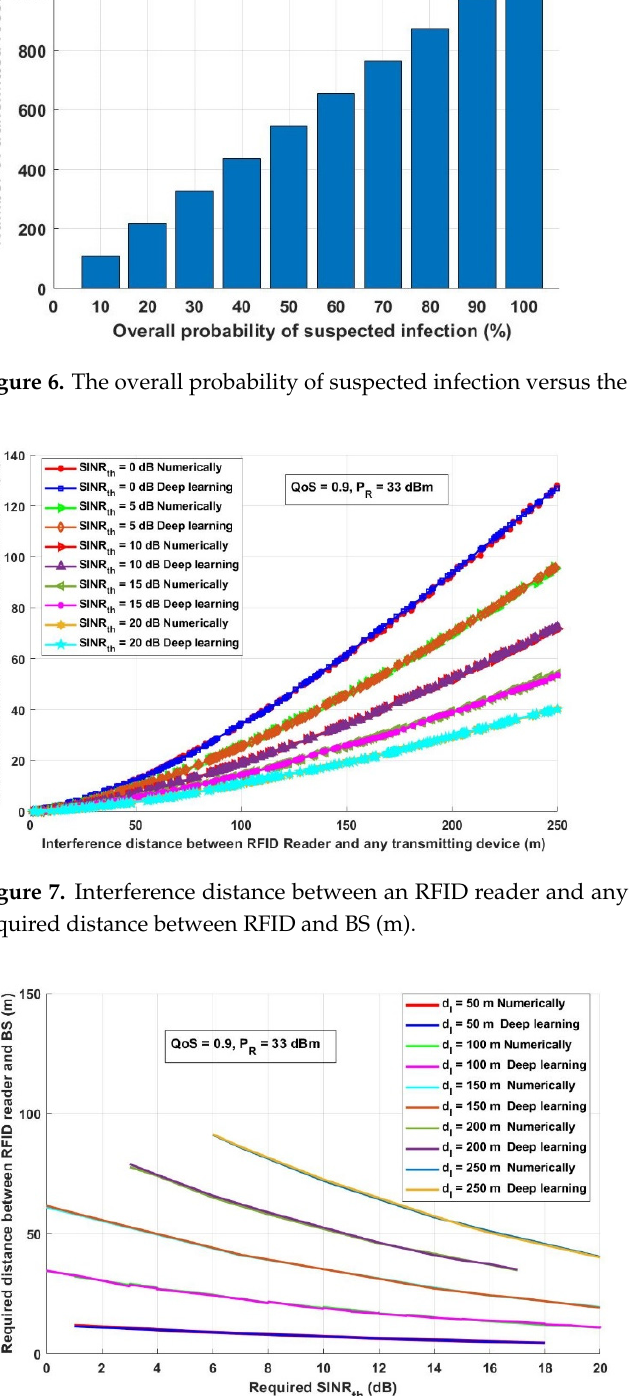
Figure 9. Required QoS versus required distance between an RFID reader and BS (m). Figure 10. RFID reader transmission power ( P R ) (dBm) versus the required distance between an RFID reader and BS (m).